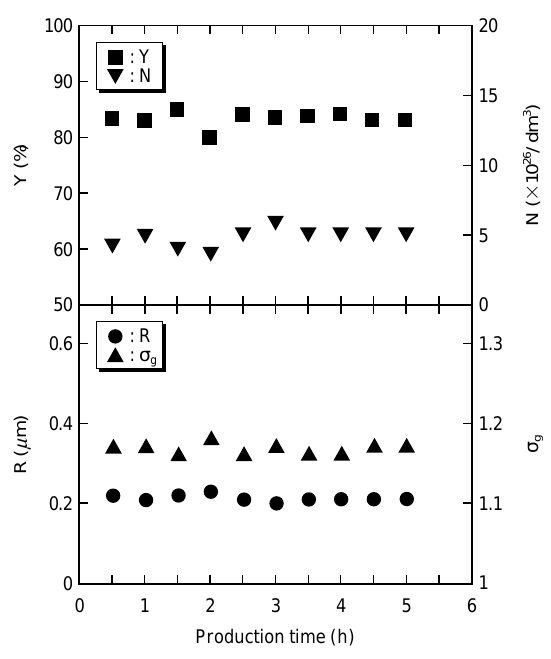
Dependence of particle size, σ g , yield, and particle number density on production time